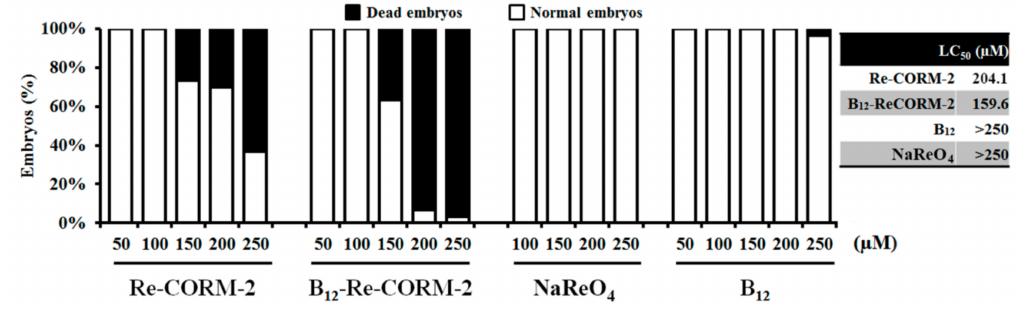
Figure 6. Toxicity evaluation of ReCORM-2, B 12 -ReCORM-2, NaReO 4, and vitamin B 12 addressed